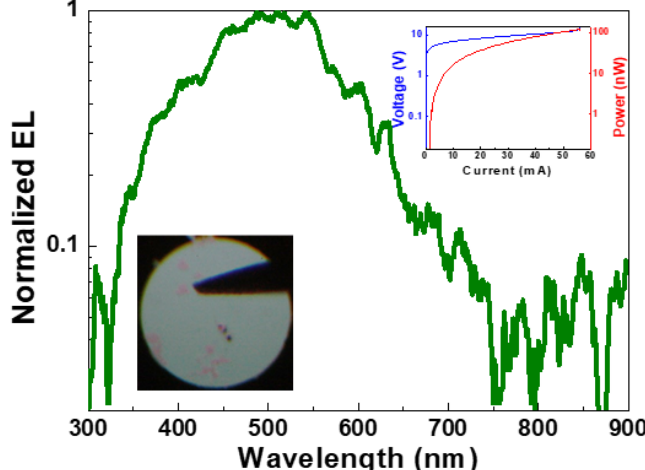
Figure 6. Electroluminescence (EL) spectrum of Si-implanted Si-QD light emitting diode (LED) with its corresponding EL pattern, voltage-current and power-current curves (Inset).